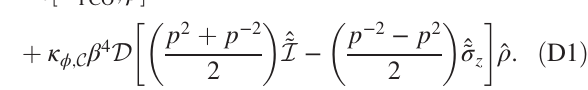
ffiffiffi p 2 . As expected, an increase in β expo- nentially suppresses the phase-flip rate.